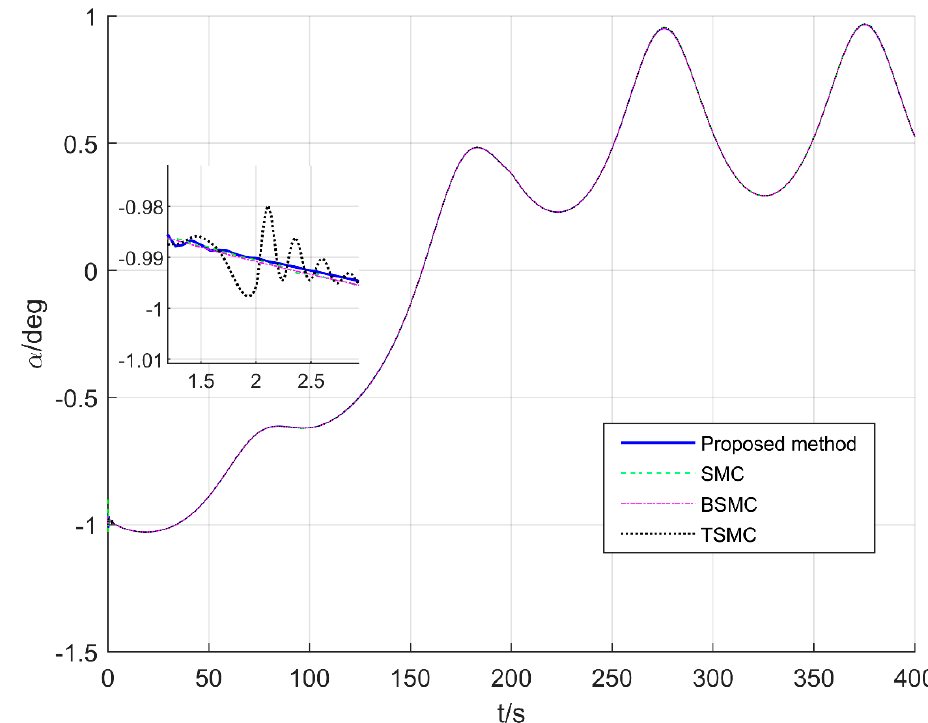
Figure 10. Responses of attack angle.